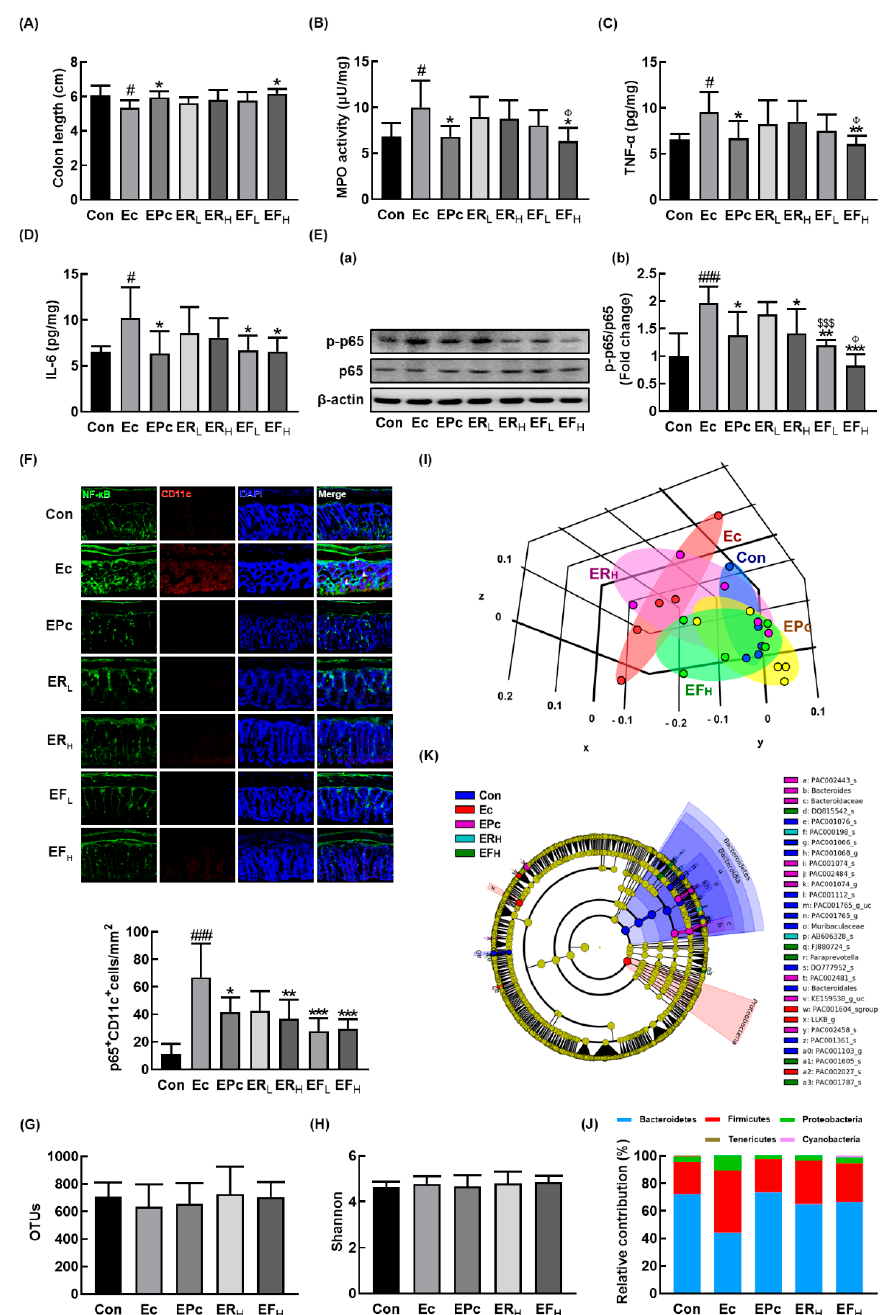
Figure 3. Oral administration of RG or fRG alleviated Escherichia coli K1 (EC)-induced colitis and gut dysbiosis in mice. Effects on colon length ( A ), myeloperoxidase (MPO) activity ( B ), TNF- α ( C ), IL-6 ( D ), NF- κ B activation ( E ( a ) and its intensity ( E ( b )), and NF- κ B + /CD11c + cells ( F ) in the colon. Effect on the composition of gut microbiota, analyzed by the pyrosequencing: operational taxonomic unit (OTUs) ( G ), Shannon ( H ), principal coordinate analysis (PCoA) plot ( I ) based on Jensen-Shannon analysis, phylum ( J ), and cladogram ( K ) generated by LEfSE indicating significant differences in gut microbial abundances among NC (blue), Ec (red), EPc (purple), ERH (blue-green), and EFH (green) groups. The threshold logarithmic score was set at 3.5 and ranked. Yellow nodes represent species with no significant difference. Mice were treated with EC and test agents as described in Figure 2. p65, p-p65, and β -actin were analyzed by immunoblotting. Blood IL-6 and corticosterone levels were assayed